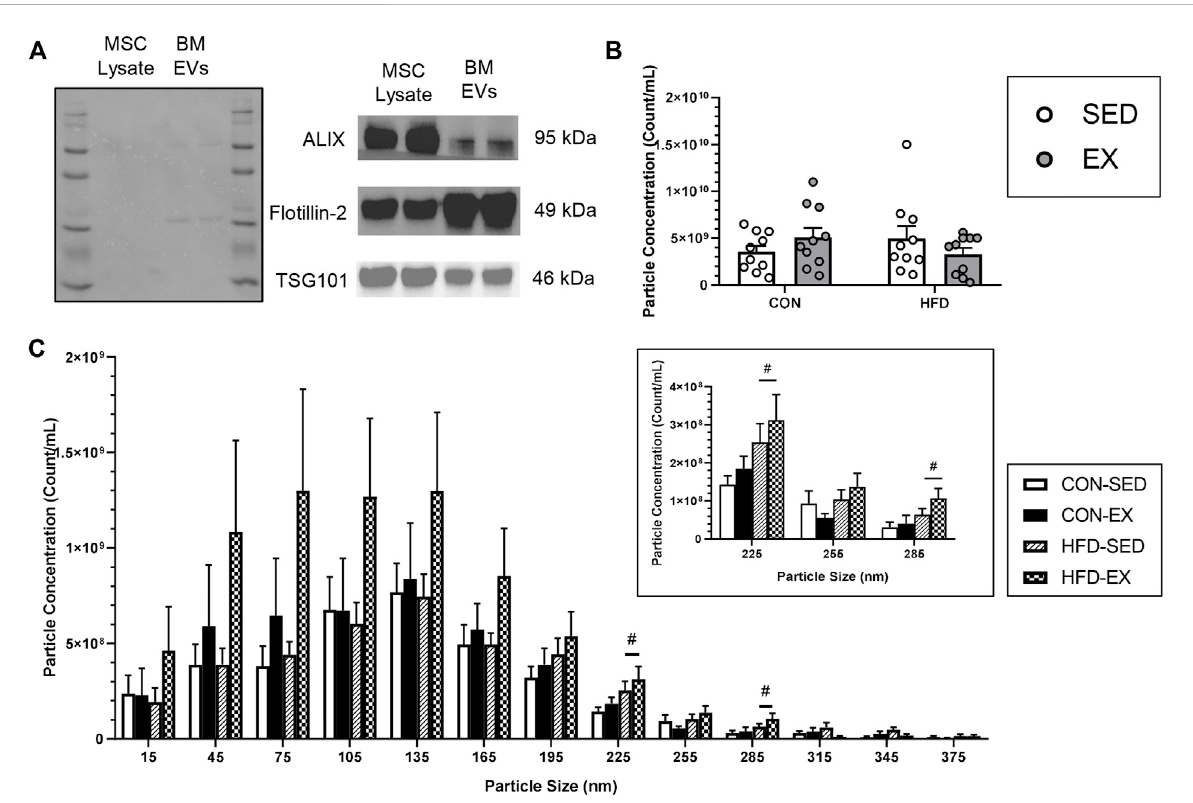
FIGURE 2 Characterization of extracellular vesicle (EVs) isolated from bone marrow supernatant of high-fat (HFD) or control (CON) diet-fed mice placed on exercise (EX)or sedentary(SED) conditions. (A) EVpresence con fi rmation bymesenchymal stromal cell (MSC) lysate positive control measures